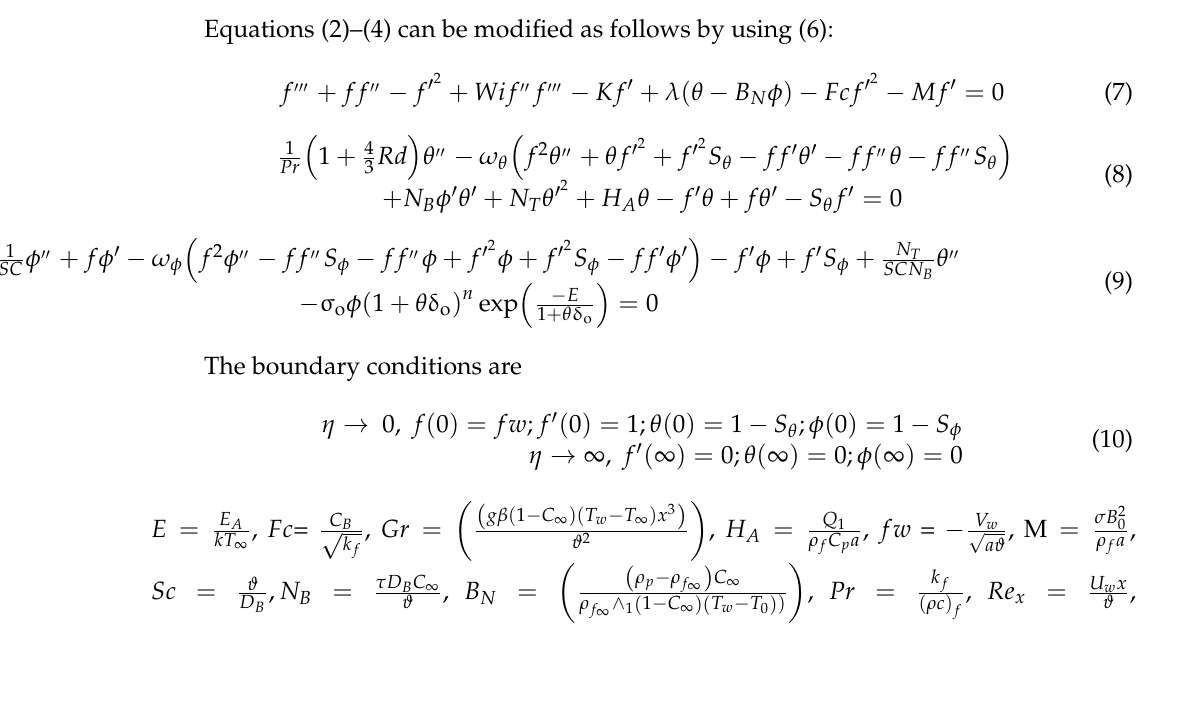
Figure 1. The geometry of the physical model.